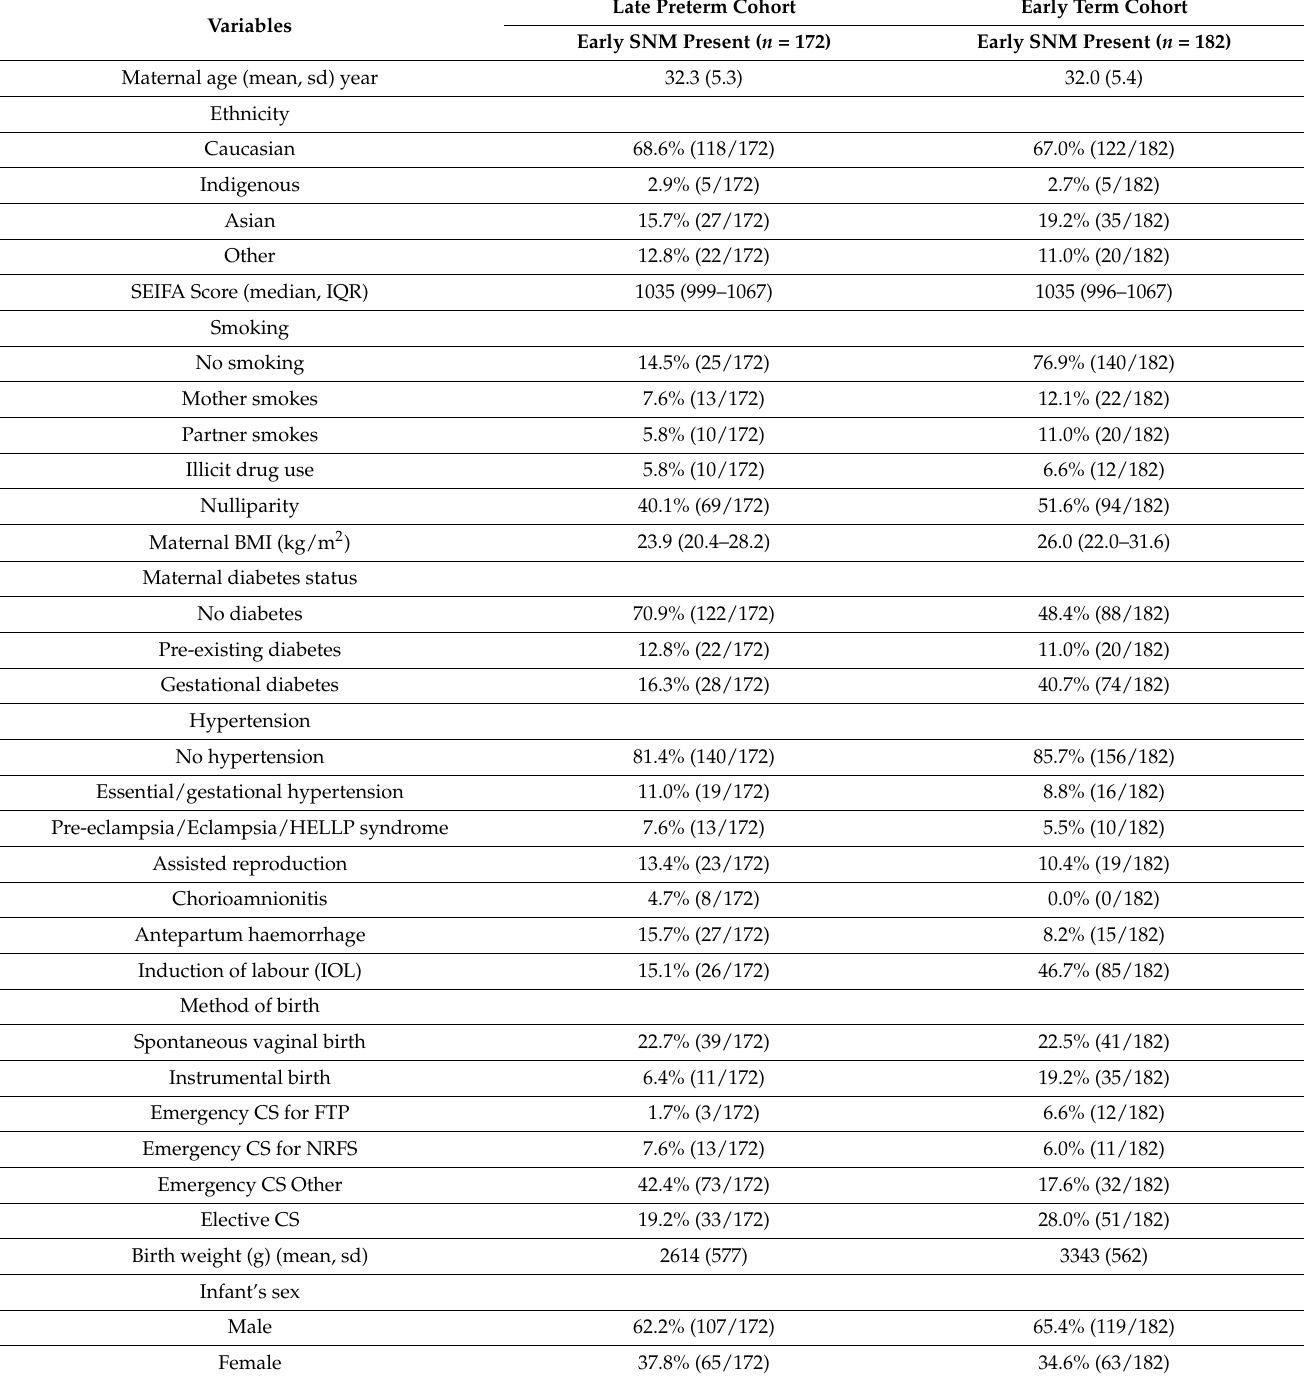
Table 1. Maternal demographics, antepartum and intrapartum